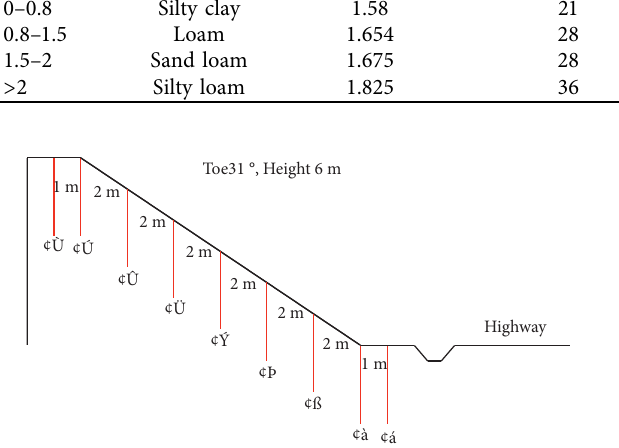
Figure 2: Detection points of cohesive soil slope (unit: